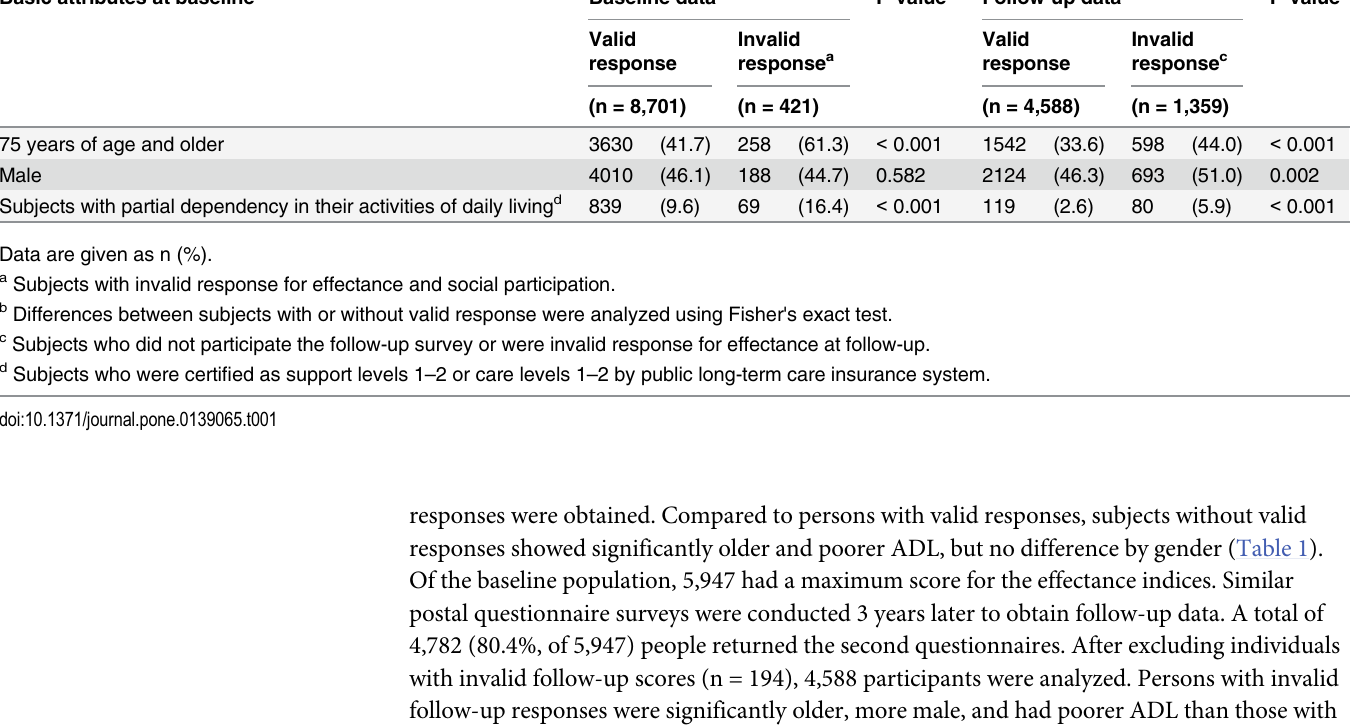
Table 1. Basic attributes of subjects with or without valid response for baseline and follow-up data. Basic attributes at